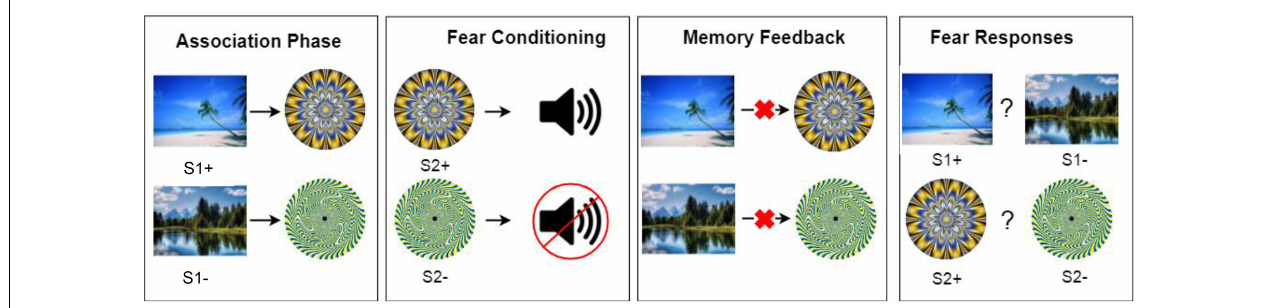
FIGURE 1 | A brief illustration of the procedure. Here illustrates one of the four picture categories (i.e., the scenery pictures). E-prime was used to present all stimuli. All S1 and S2 materials were generated from Wang et al. (2019).